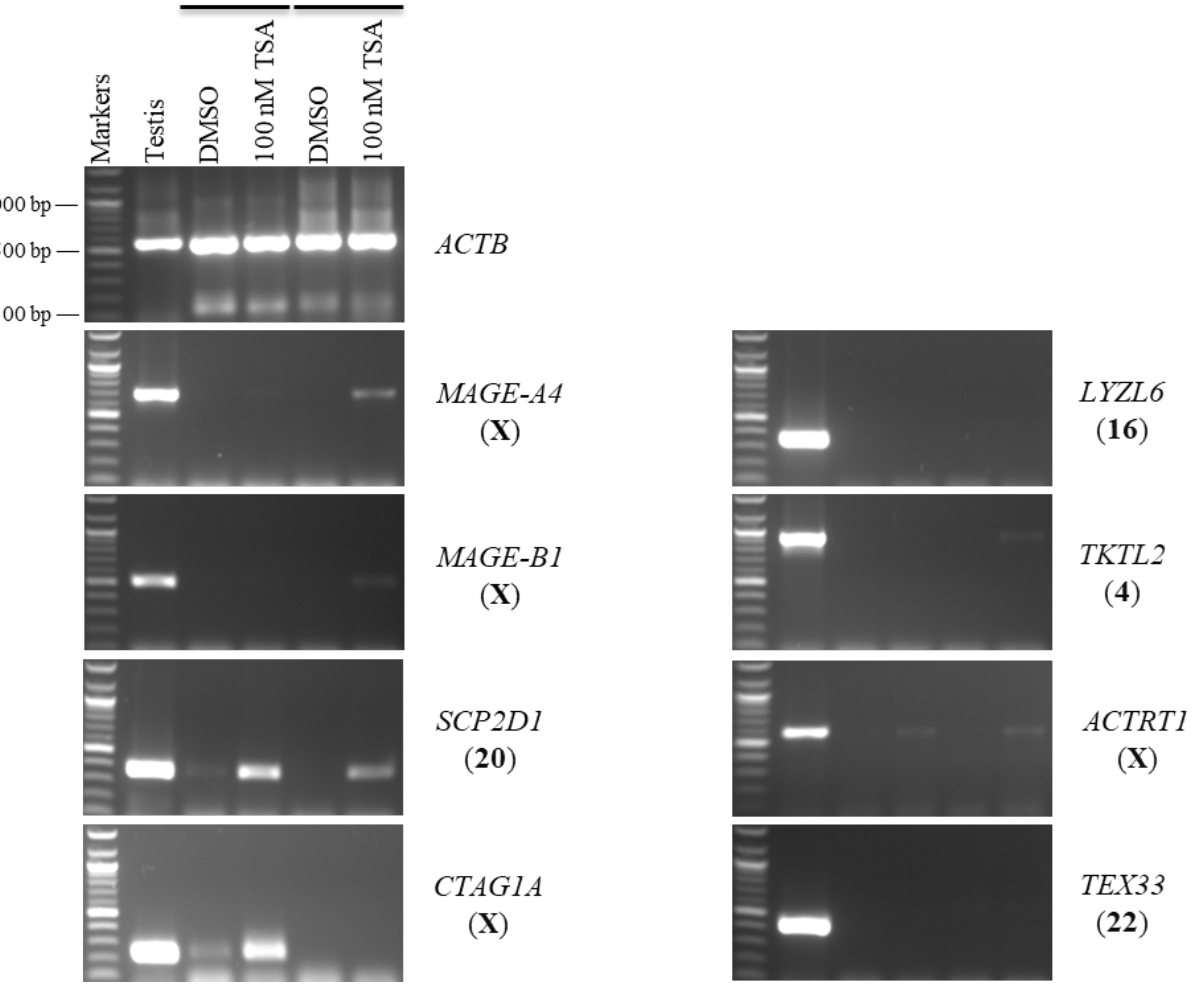
Figure 3. The effects of TSA treatments on CT gene expression profiles in the Caco-2 and HCT116 cancer cell lines. The expression of SCP2D1 , CTAG1A , LYZL6 , TKTL2 , ACTRT1 , and TEX33 genes is shown on agarose gels following treatment with 100 nM of TSA for 48 h. The testis sample served as a positive control for primer efficiency. Control Caco-2 and HCT116 cells were treated with DMSO, as DMSO was the solvent utilized in the TSA solution. The positive control for the cDNA samples is the expression of the ACTB gene. The official names of the genes are written to the right of the agarose gel images, and the location of each gene on the chromosomal is written in parentheses on the